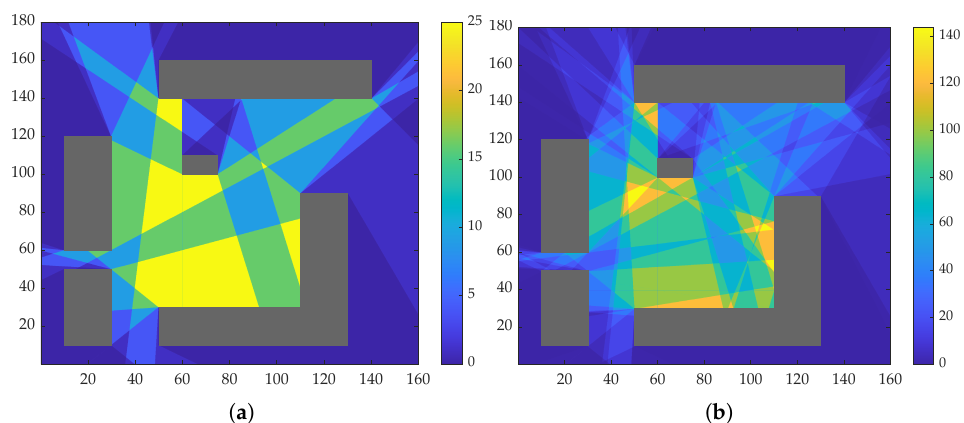
Figure 5. Number of round-trip multipaths in the study area: ( a ) Reflection is limited to single-bounce; ( b ) reflection is limited to double-bounce.